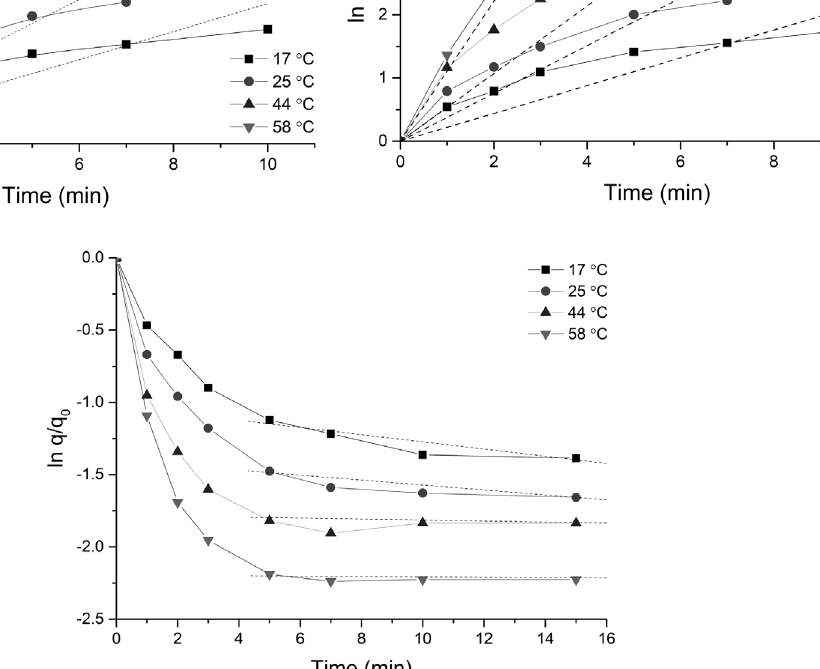
Figure 3: The dependence of (a) ln [ C (the dashed line shows a linear